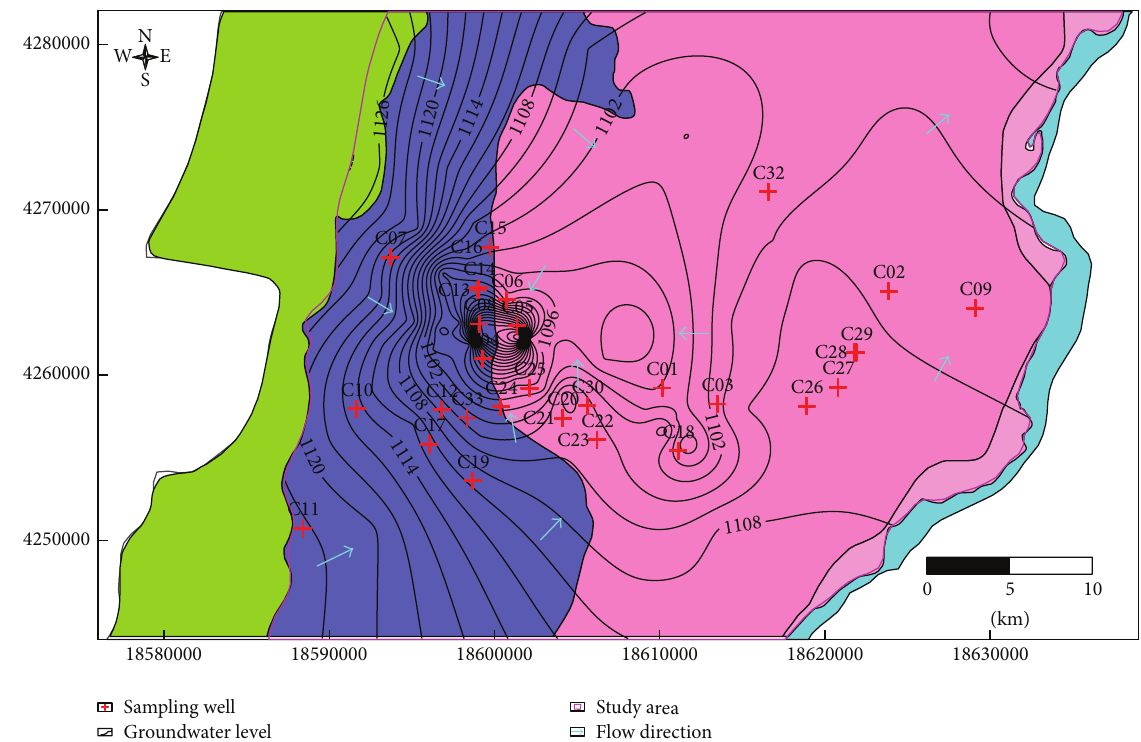
Figure 3: Hydrogeological map of confined aquifer and sampling wells in the study area (m).